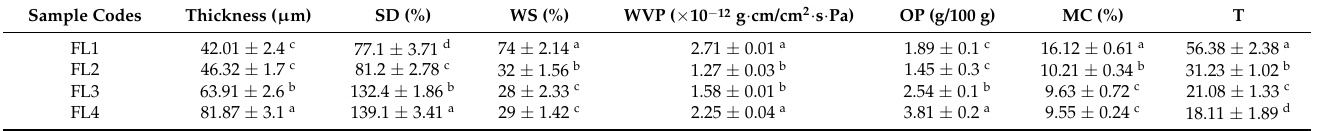
Table 3. Thickness, water vapor permeability (WVP), oxygen barrier property (OBP), water solubility (WS), swelling degree (SD), moisture content (MC), and transparency (T) of CA–SA and CA–SA–OEO